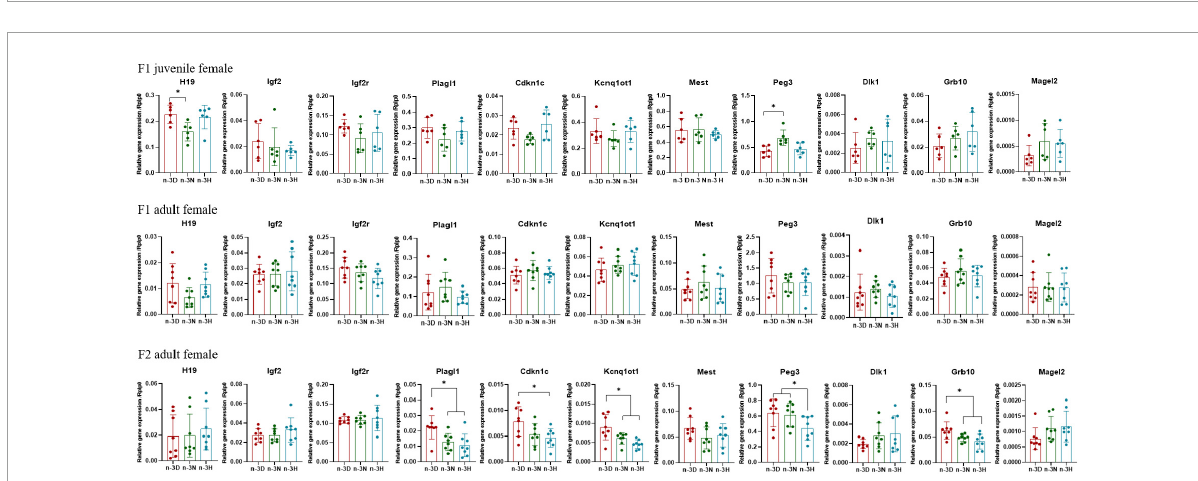
FIGURE4 Effects of paternal dietary ratio of n-6: n-3 PUFAs on the expression of imprinted genes in the adipose tissue of female offspring. The protocols for production of F1 and F2 offspring as well as the experiments were the same as those described in Figure 1 . Mice from the F1 or F2 offspring were fed normal chow diet for 16 weeks. The mRNA expression of the imprinted genes in the epididymal fat was measured using real-time qPCR. n = 6–8 mice in each group. Data have been presented as mean values with standard deviation. * P < 0.05. Statistical differences were analyzed by one-way analysis of variance with Bonferroni post hoc , or Dunnett’s T3 test for data lacking homogeneity of variance. For non-normally distributed data, the Kruskal–Wallis test was used with Mann-Whitney U post hoc